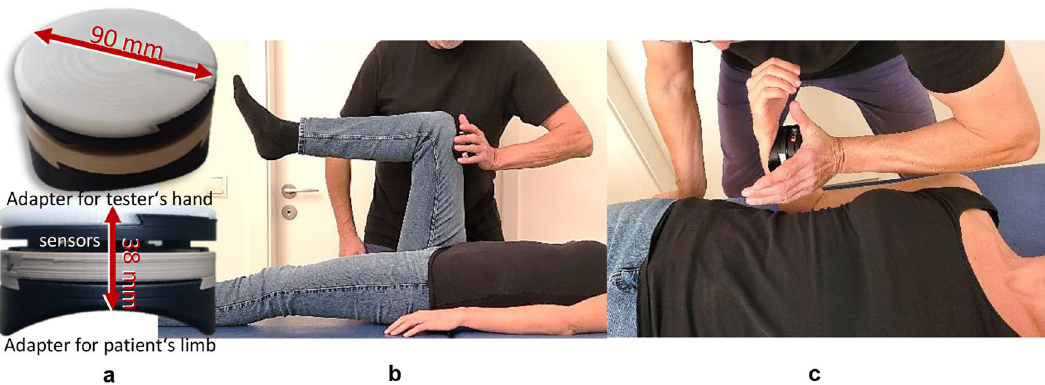
Figure 3. Setting of the manual AF measurements. The handheld device ( a ) is placed between the palm of the tester and the limb of the participant; ( b ) manual muscle test (MMT) of the hip flexors; ( c ) MMT of the elbow flexors. The sniffing stick (olfasense) is held by the participant to his or her nose to smell the odour during the